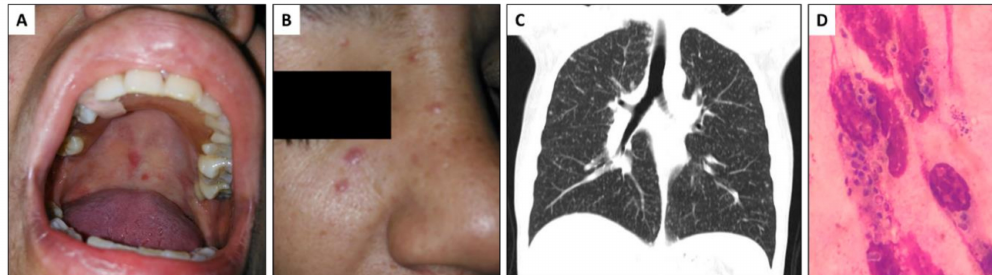
Figure 1. Clinical findings: ( A , B ) Papule-like lesions in the right malar region and in the proximal area of the nose and erythematous lesion with slight central ulceration in the central palate. ( C ) Chest computed tomography (CT), without contrast, revealed a bilateral and di ff use micronodular interstitial pattern, compatible with miliary histoplasmosis. ( D ) Wright-Giemsa stain on sputum smear, intracellular clusters of budding yeast compatible with H. capsulatum using Wright-Giemsa